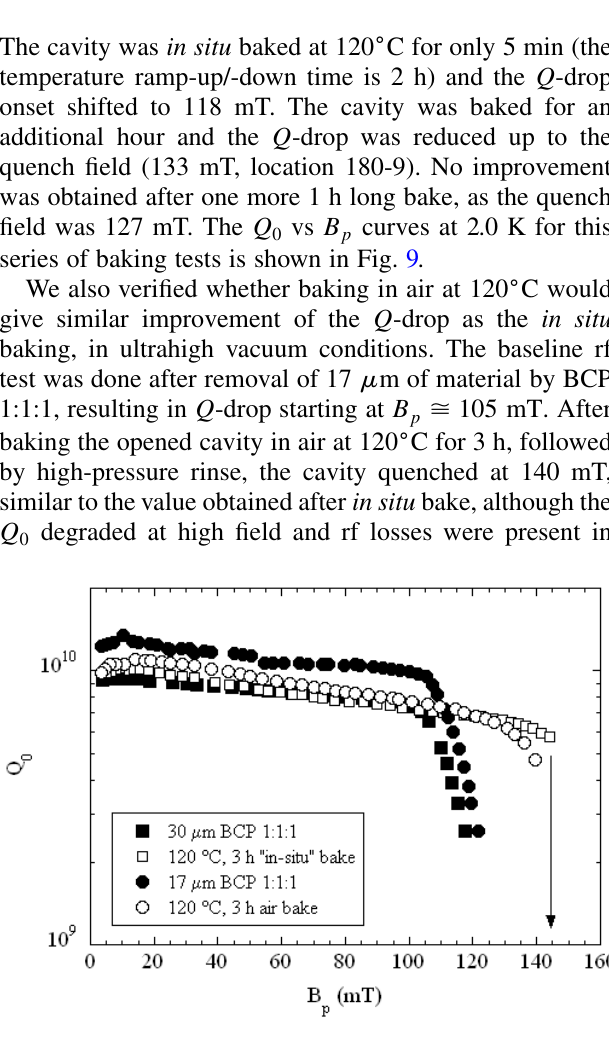
FIG. 10. Q vs B measured at 2.0 K after etching by BCP p 0 1:1:1 followed by in situ baking at 120 (cid:3) C for 3 h and after another chemical etch followed by air baking with the same parameters as for the in situ